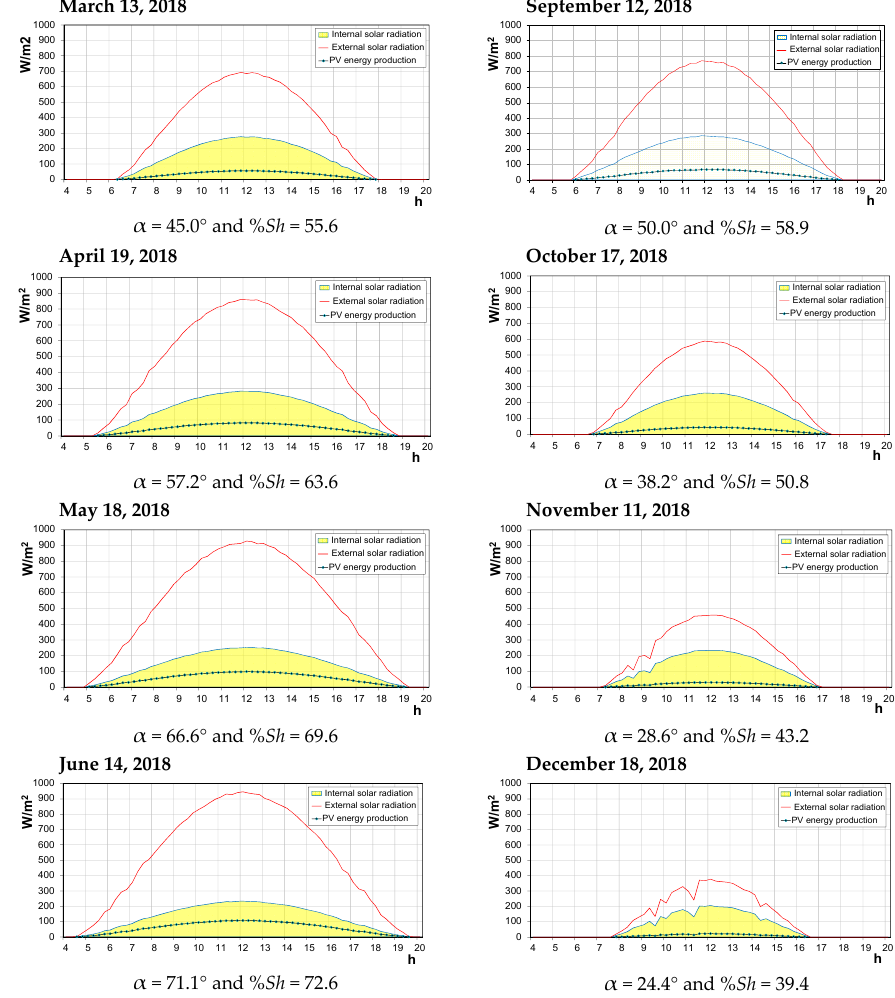
Figure 7. Annual distribution of internal solar radiation for different percentage shading (% Sh ) and PV energy production.